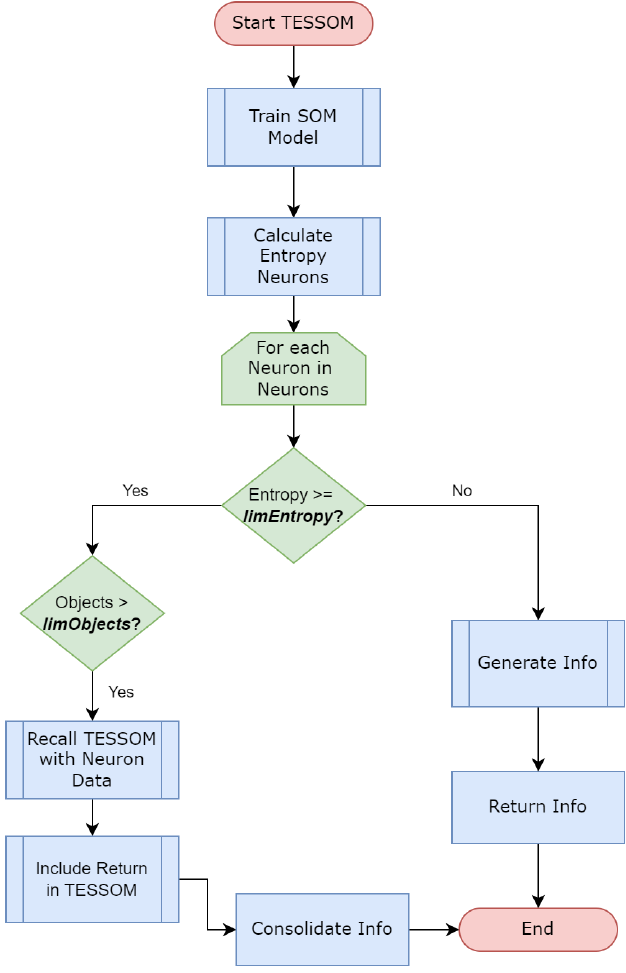
Figure 3. TESSOM